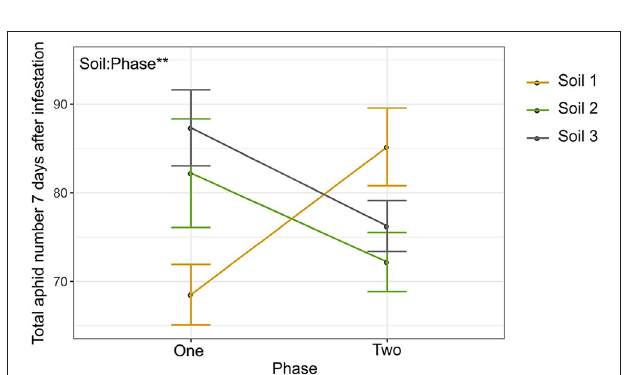
FIGURE 7 | Soil microbial community source affects legacy impacts on herbivore performance. Interaction plot showing mean aphid performance between Phase 1 and 2. Error bars represent standard error of the mean. Significant factors are shown (** p <